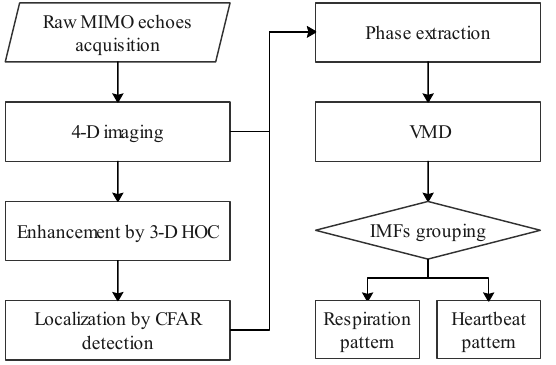
Figure 3. Flowchart of the proposed